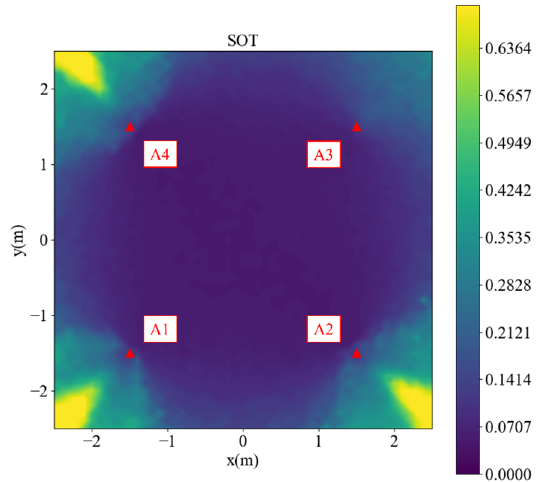
Figure 2. Simulated root ‐ mean ‐ square error (RMSE) of the second ‐ order Taylor (SOT) method.